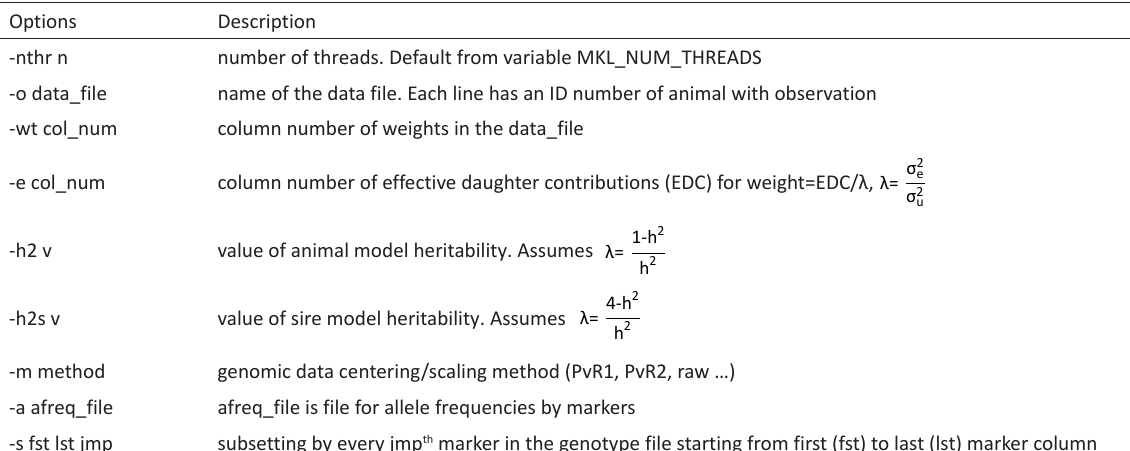
Table 1. Main options for snp_blup_rel describing the data format and desired